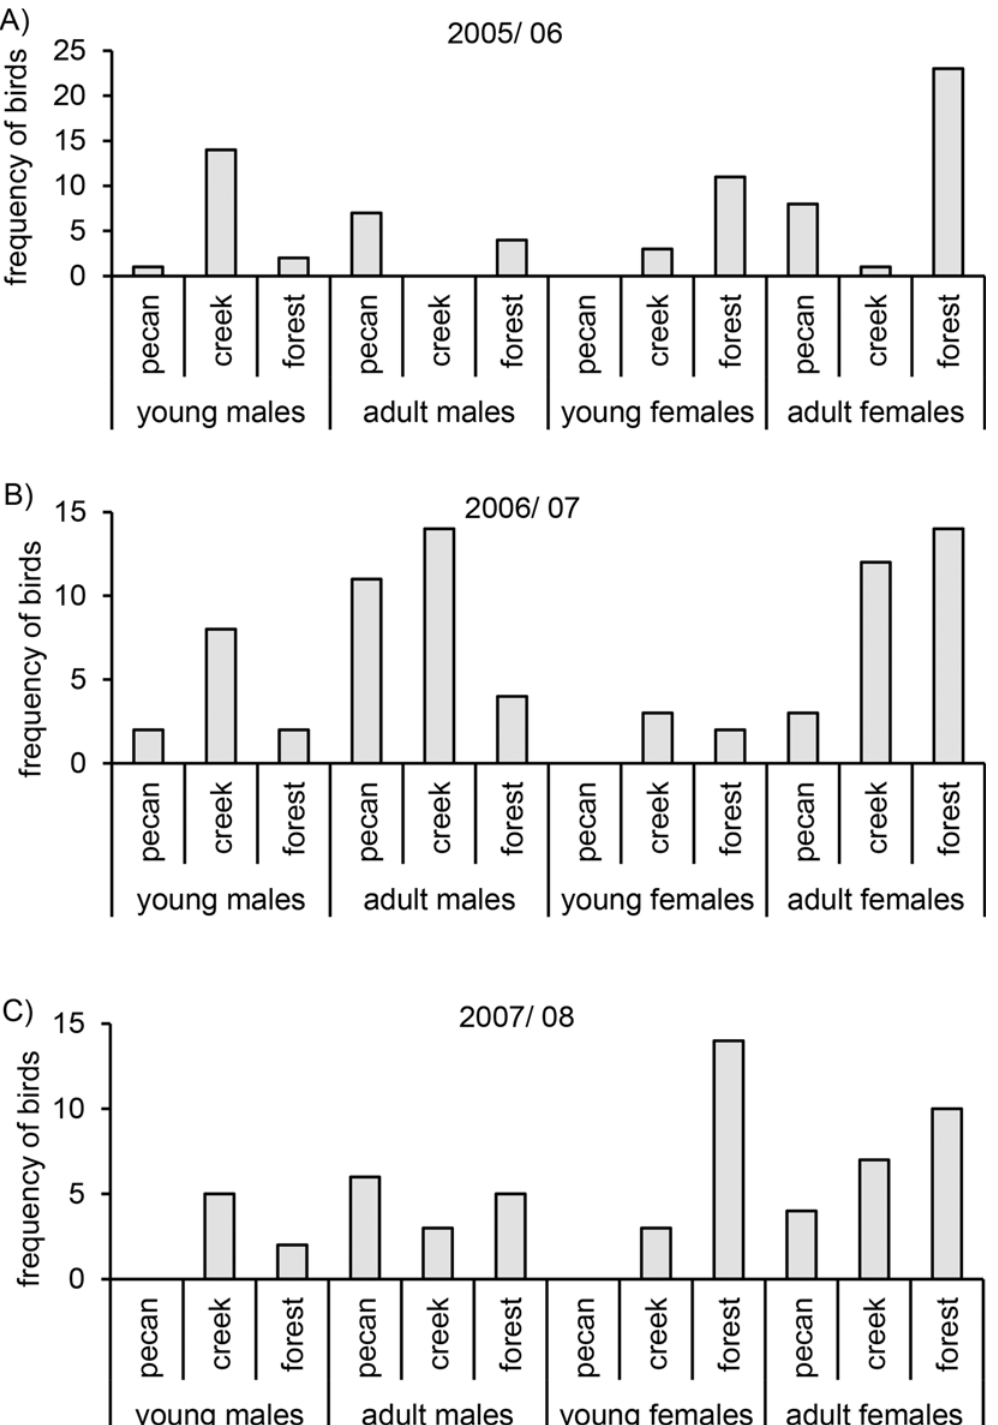
Fig 2. Age and sex composition in different habitats. Frequency of age and sex classes captured in pecan groves, forest fragments along creeks and forests in three consecutive winters. Frequencies of age and sex classes were summed up for sites of the same habitat type within a given year.